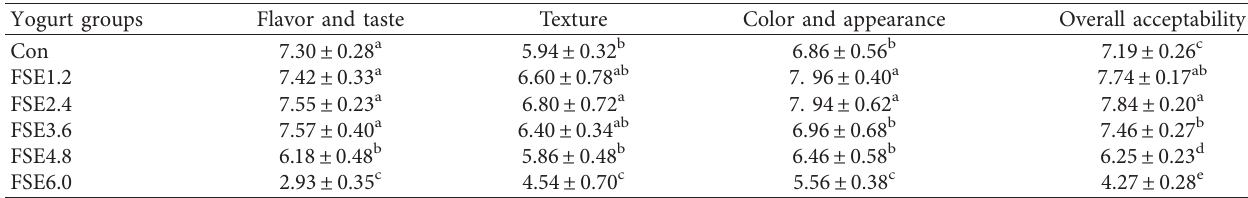
Figure 3: Co-supplementing different contents of TP with 2.4% FSE affected the rheological properties of yogurts: (a) G ′ (storage modulus) and (b) G ″ (loss modulus). FSE: Flos Sophorae extract; TP: Tremella fuciformis polysaccharides; Con: the yogurt without FSE or TP; based on 2.4% FSE, the different concentrations of TP (0, 0.2, 0.4, 0.6, and 0.8mg/mL milk) were added to produce FSE2.4, FSE-TP0.2, FSE-TP0.4, FSE-TP0.6, and FSE-TP0.8 yogurts. Table 1: Effect of supplementing different concentrations of FSE on sensory scores of low-fat yogurts. Yogurt groups Flavor and taste Texture Color and appearance Overall